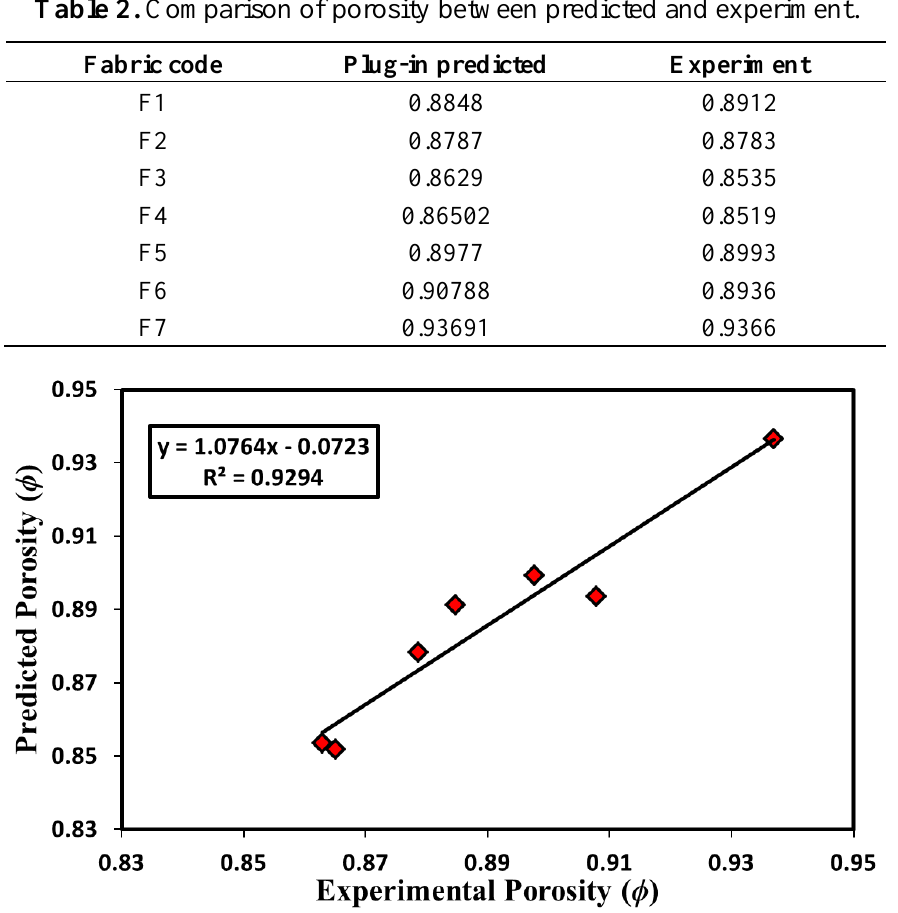
Table 2. Comparison of porosity between predicted and experiment.